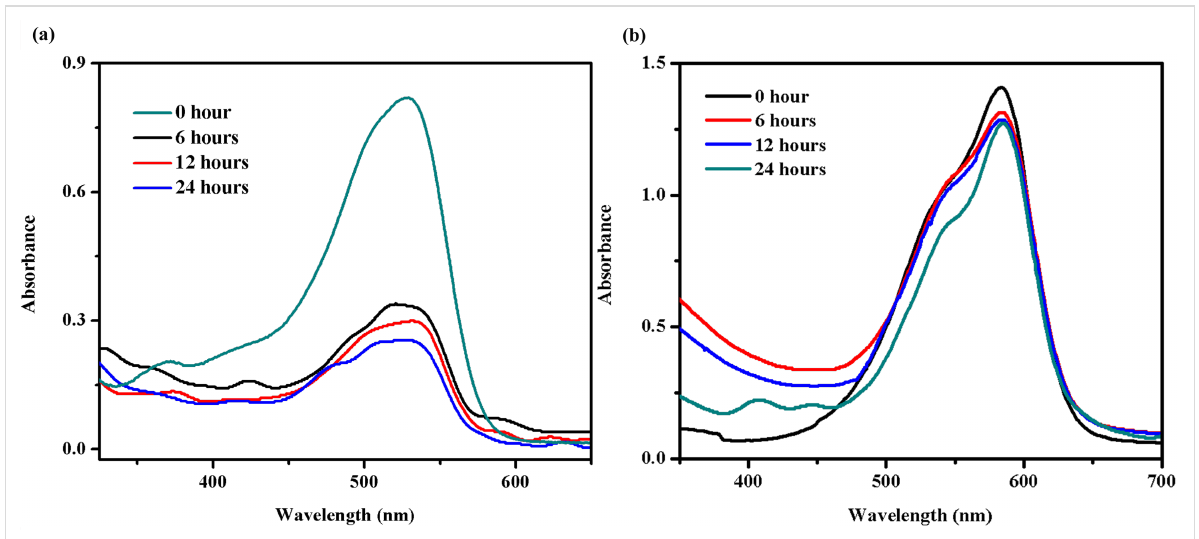
Figure 10: Time-dependent UV–vis absorption profile of (a) Direct Red 80 (b) Crystal Violet aqueous dye solution (0.02 mM) by TPM-G12 gel (1% w/v in propan-1-ol).